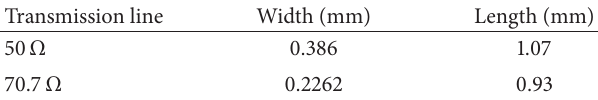
Table 2: Lengths and widths of 50 Ω and 70.7 Ω